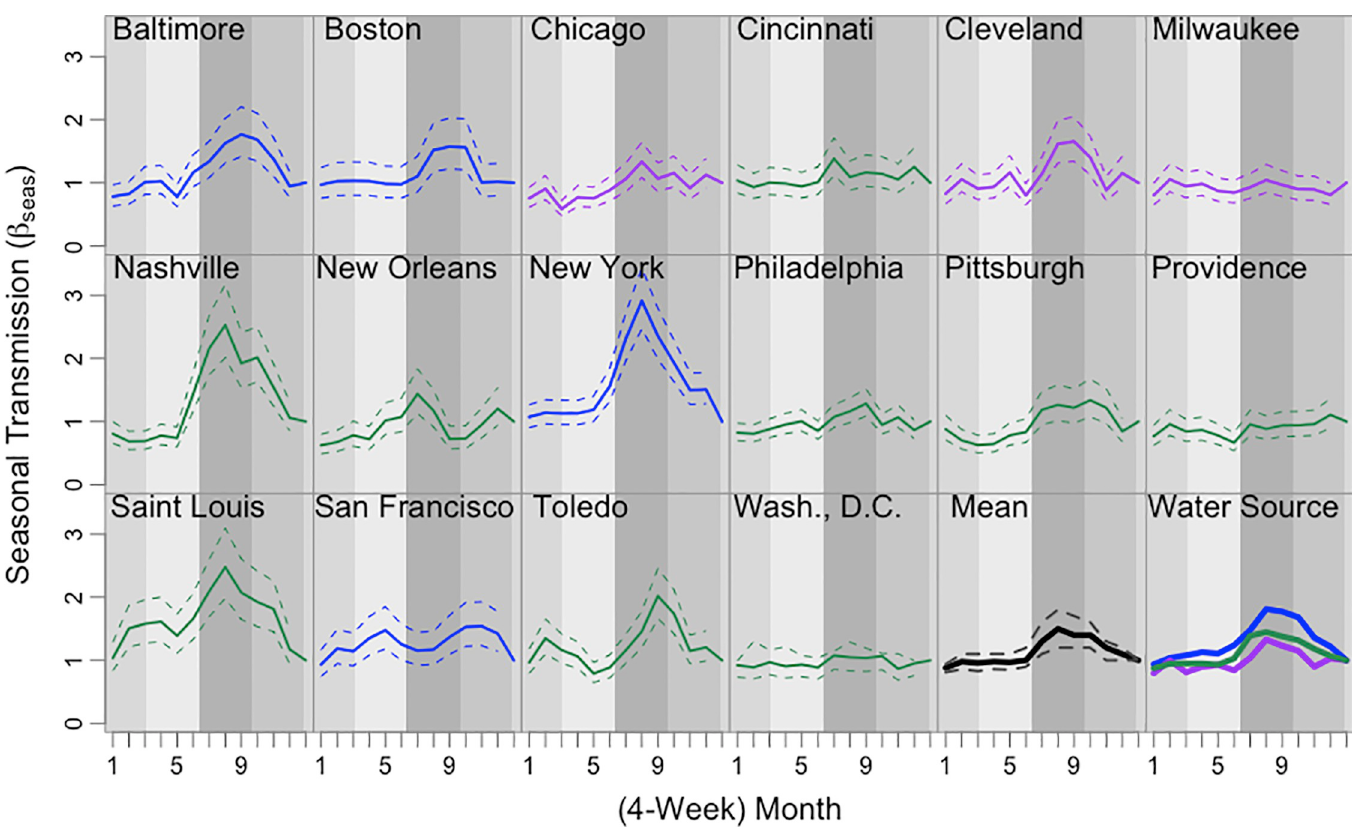
Fig 1. Annual seasonal typhoid transmission estimated from Time-series Susceptible-Infectious-Recovered models. The estimated seasonal transmission rate in each 4-week period is plotted for each city (color-coded by water source type; solid lines are the mean estimates and dashed lines are the 95% confidence intervals). The second- to-last panel shows the mean seasonal transmission across all cities in bold black. The last panel shows the mean seasonal transmission rate for cities with a particular water source type, with reservoirs in blue, rivers in green, and Great Lakes in purple. Seasons are shown in the background in shades of grey (medium-light grey for winter, light grey for spring, dark grey for summer, and medium-dark grey for